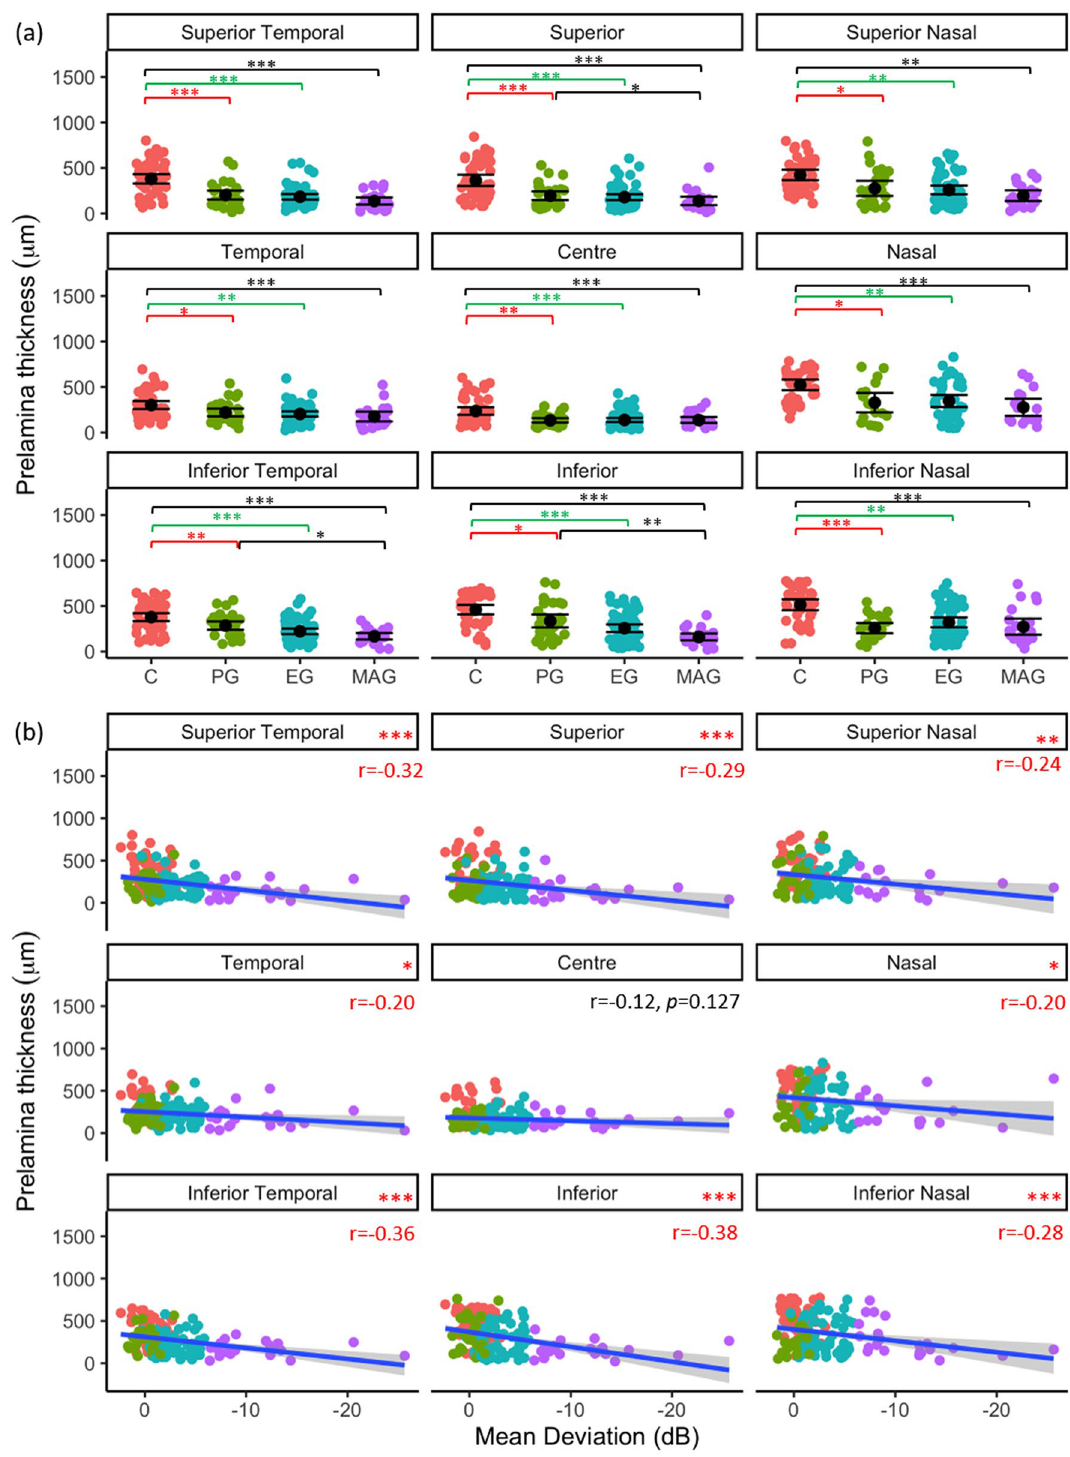
Figure 6. Regional prelamina thickness as a function of glaucoma disease stage ( a ); black point represents mean and error bars indicate 95% confidence intervals, and ( b ) visual field status (VFMD). Blue line represents regression line and grey shading indicates 95% confidence intervals. Red text indicates significant Pearson’s correlation (r) values at p < 0.05. * p < 0.05, ** p < 0.01, *** p <